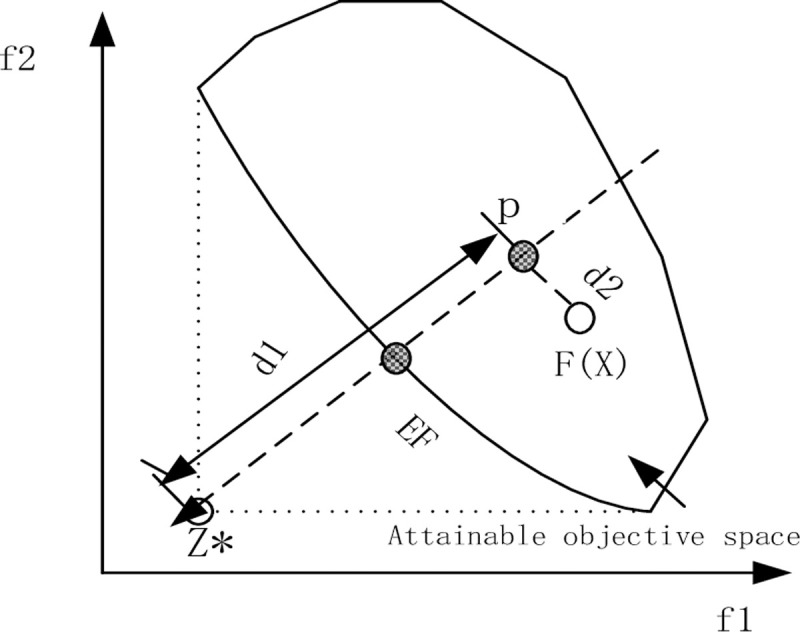
Illustration of PBI approach [13].